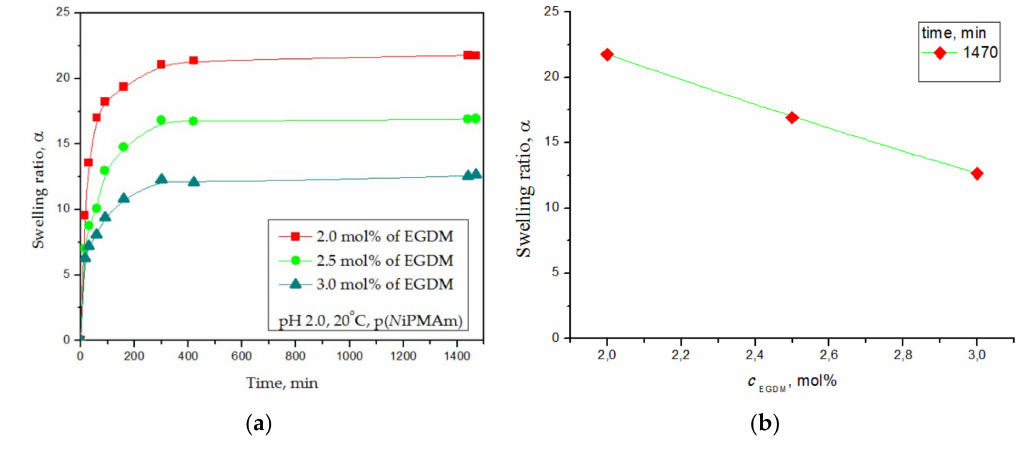
Figure 5. Swelling ratio, α , of the poly( N -isopropylmethacrylamide) hydrogels at 20 ◦ C and pH = 2.0 depending on ( a ) time and ( b ) EGDM